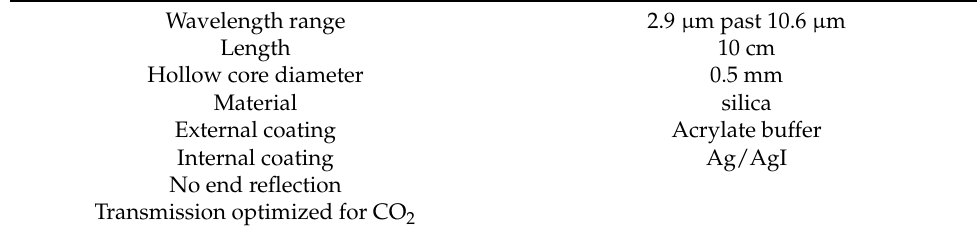
Table 5. Specifications of the hollow fiber.